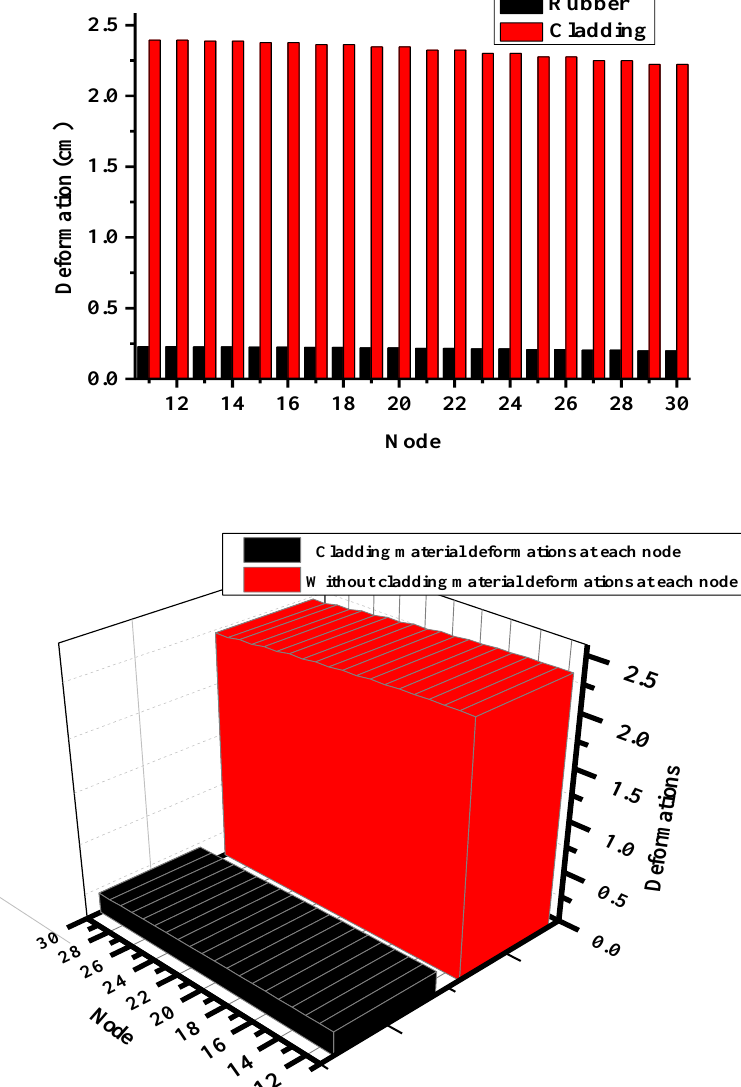
Fig. 7. Maximum deformation of cladding and